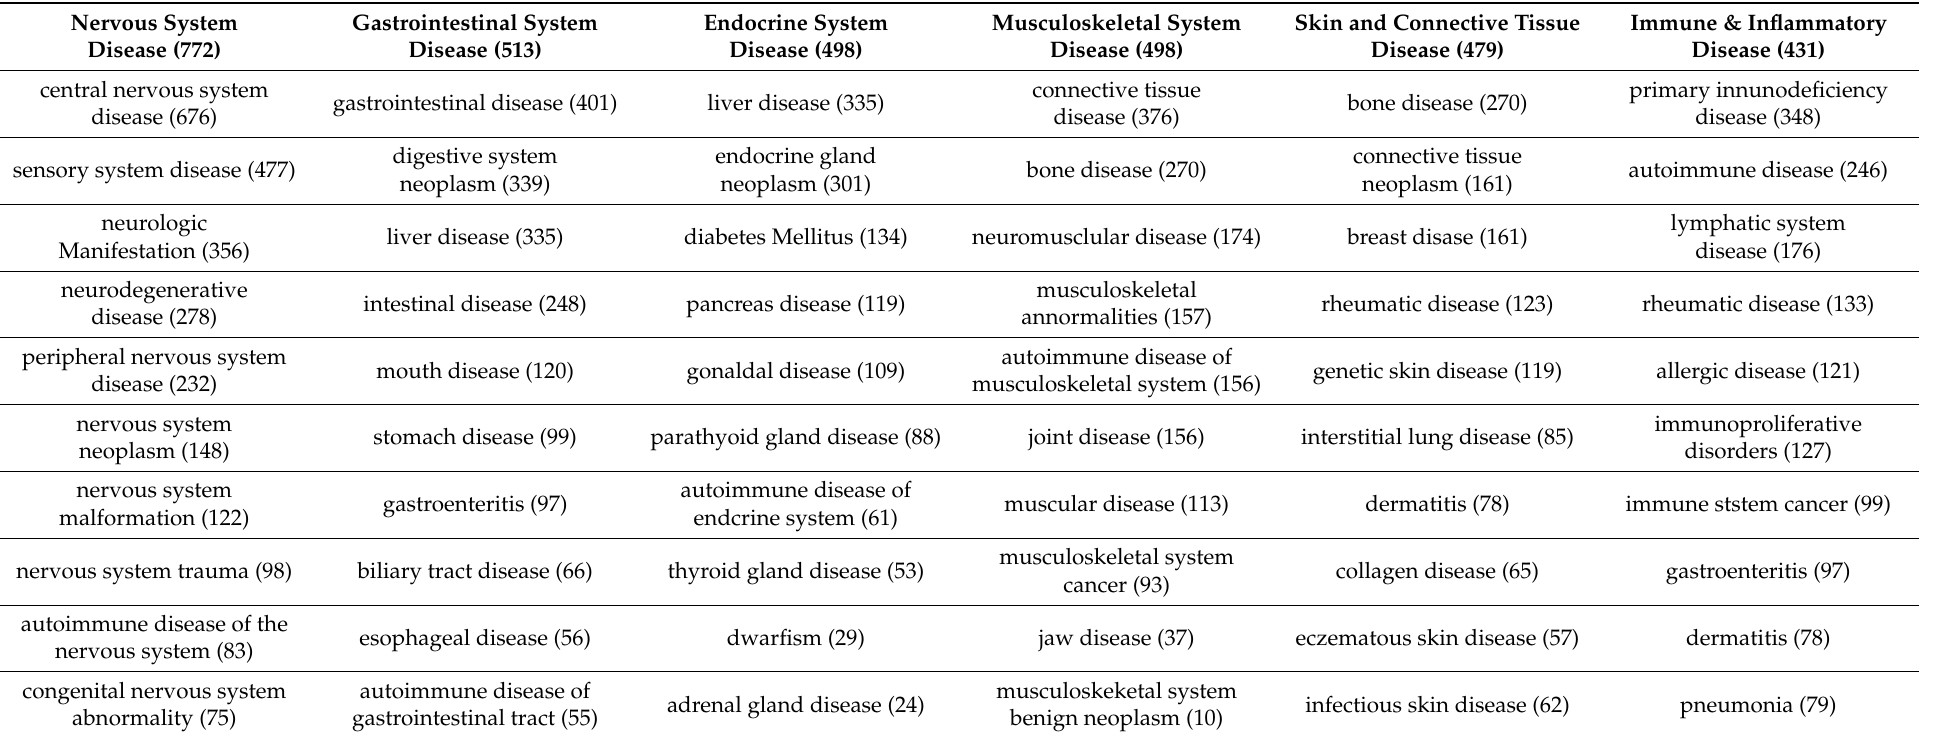
Table 3. COVID disease gene distribution within organ